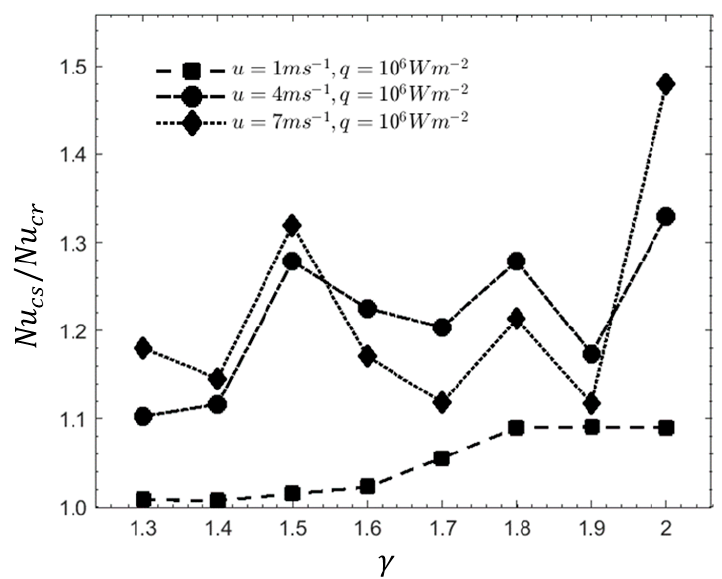
Figure 7. Nu cs /Nu cr against γ Figure 7. Nu (cid:2913)(cid:2929) /Nu (cid:2913)(cid:2928) against 𝛾 .